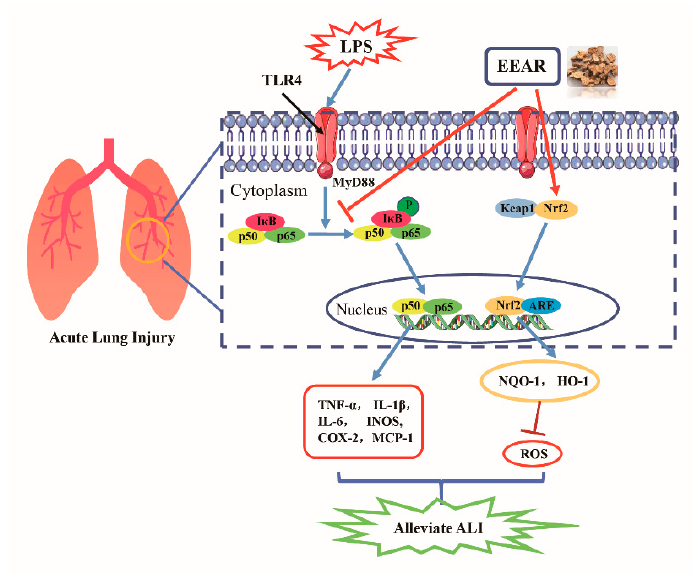
Figure 10. EEAR attenuates oxidative stress and inflammatory responses via TLR4/NF- κ B and Keap1/Nrf2 signaling pathways to alleviate LPS-induced ALI.